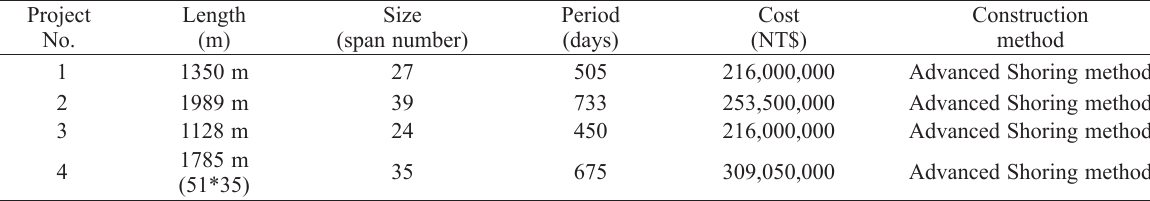
Table 5. Basic information of four advanced shoring bridge construction projects Project No.